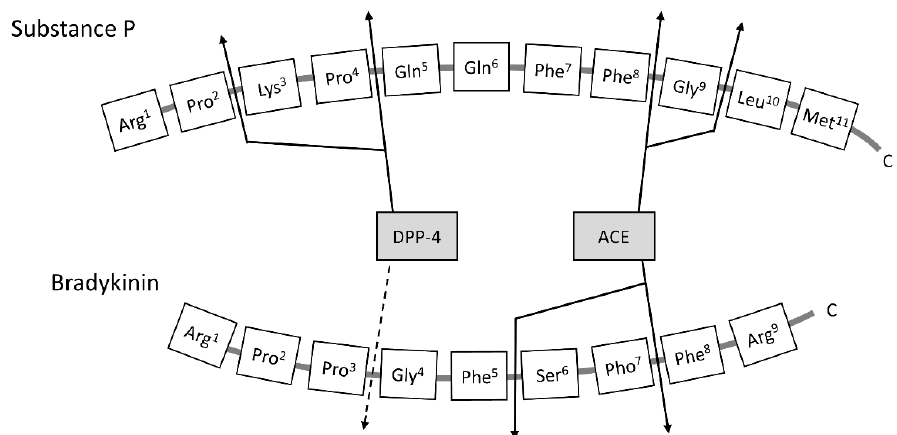
Figure 1. Sites of action of angiotensin-converting enzyme and dipeptidyl peptidase-4 in the metabolism of substance P and bradykinin.